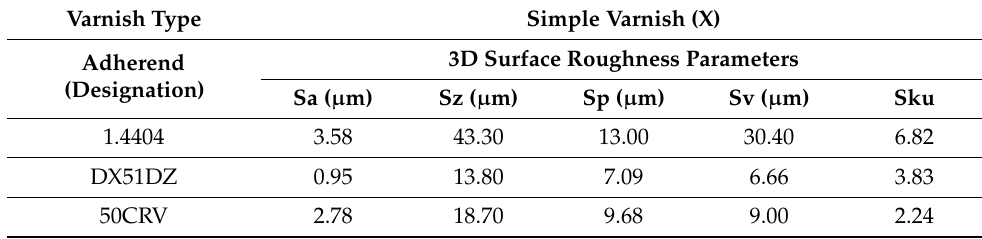
Table 15. Average values of 3D height parameters.